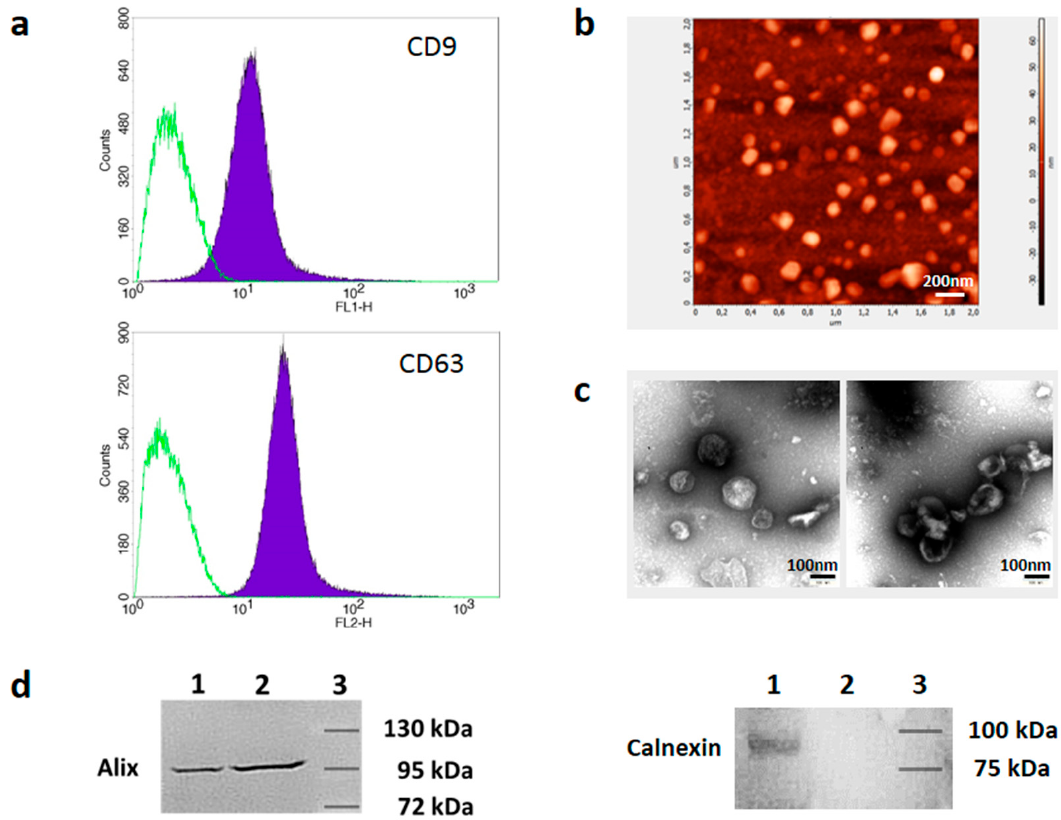
Figure 1. Characterization of melanoma cell-derived sEVs. ( a ) sEVs were adsorbed to latex beads, stained with anti-CD9-FITC and anti-CD63-PE antibodies, and analyzed by flow cytometry (filled peaks). Isotype control antibodies (open peaks) were used to demonstrate the specificity of staining (representative of n = 4). ( b ) Atomic force microscopy image of melanoma cell-derived sEVs. Scale bar, 200nm. ( c ) Images of melanoma-derived sEVs were obtained by TEM (transmission electron microscopy). Scale bar, 100nm. ( d ) Western blot analysis of cellular lysates (lane 1) and sEV lysates (lane 2) using antibodies binding to Alix or Calnexin, as indicated. Lane 3 shows the position of the marker bands. The molecular weight is indicated.